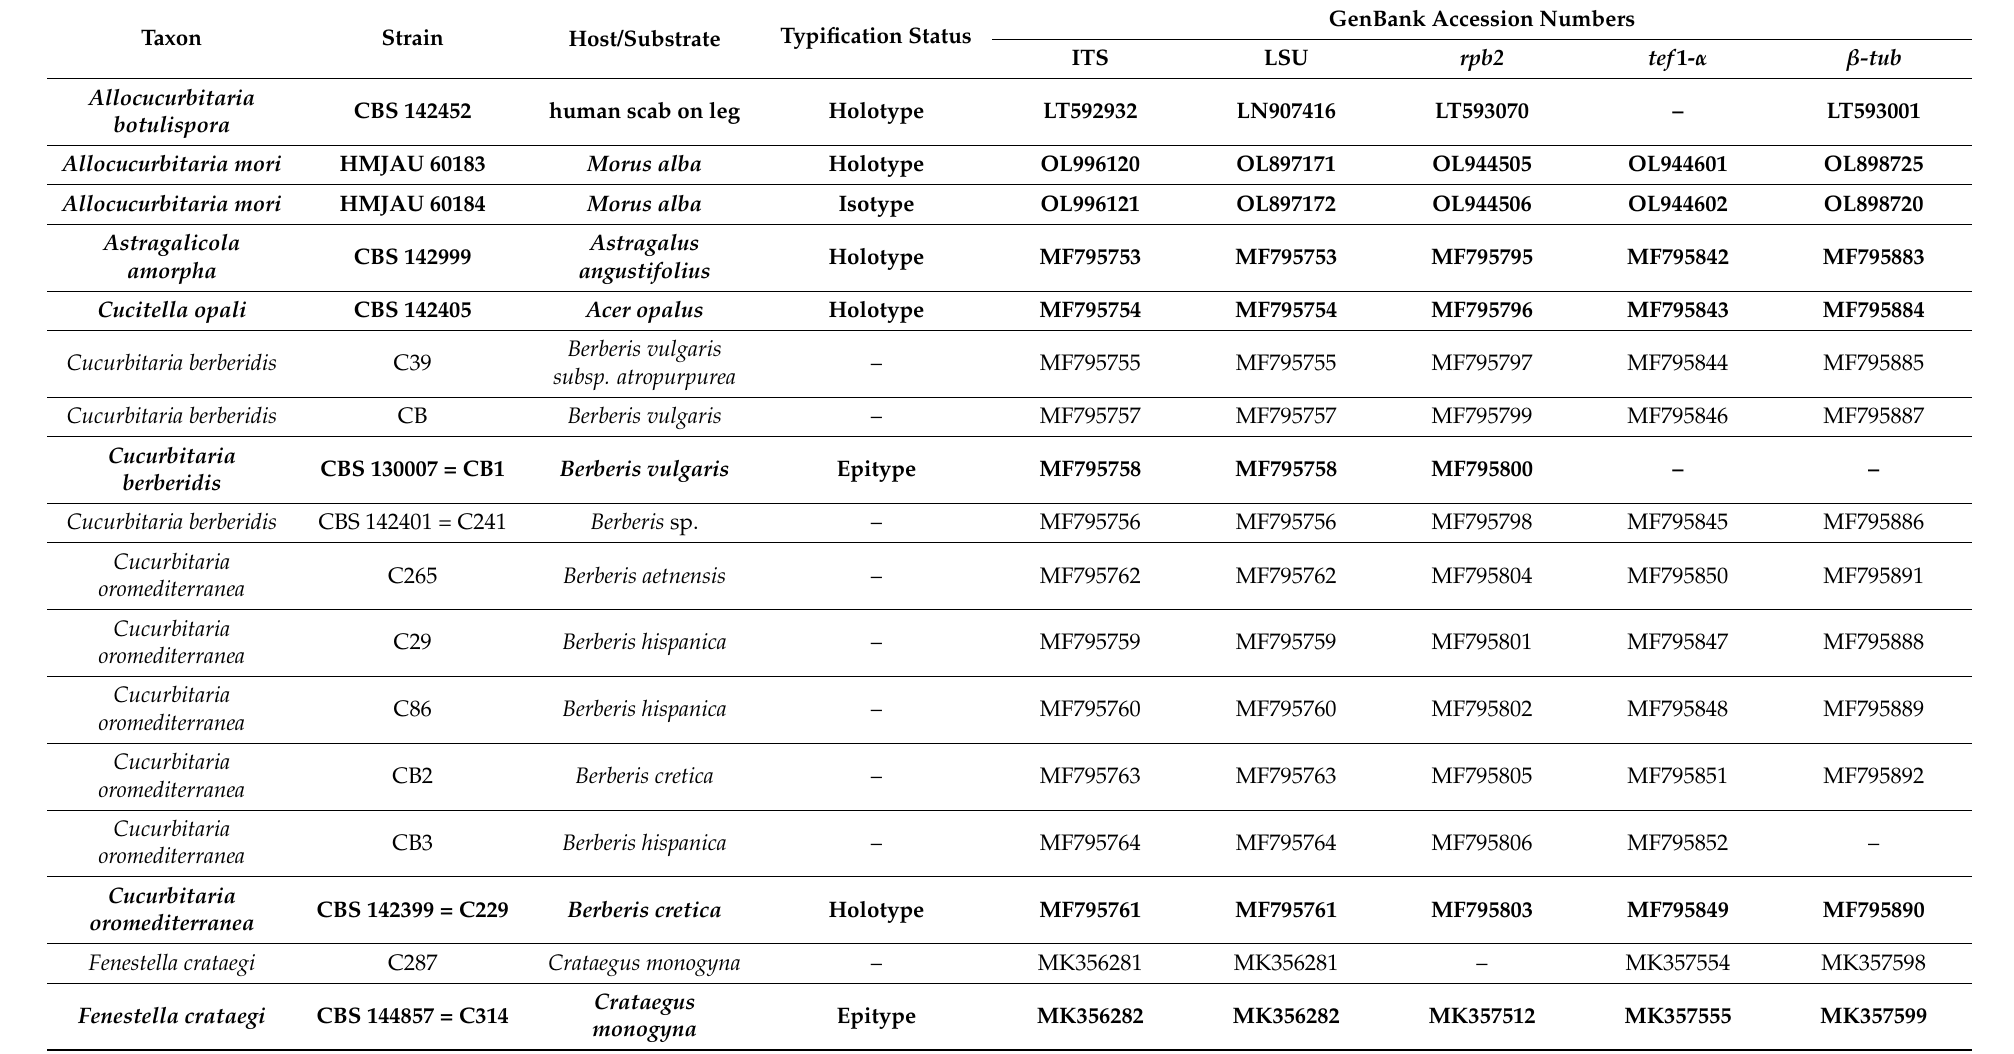
Table 2. The dataset used for phylogenetic analysis. The type-derived sequences are in